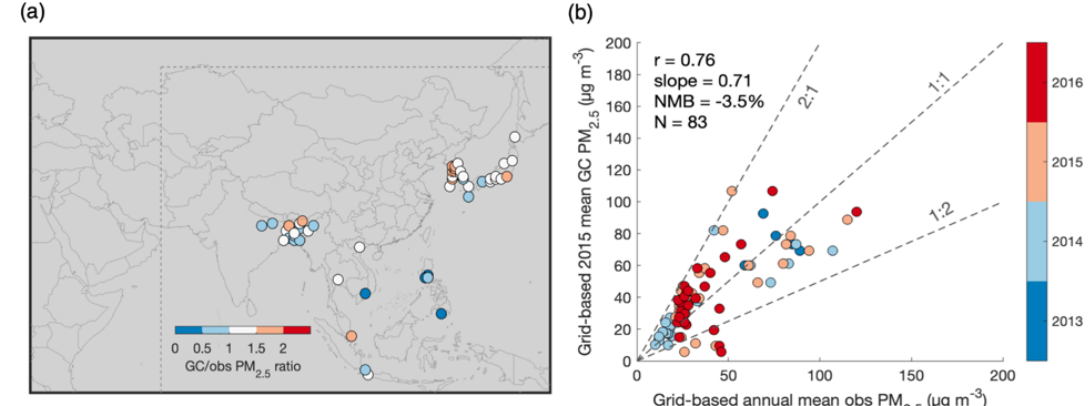
Figure 2. Annual-mean PM 2 . 5 concentrations at anthropogenic-emission-dominated sites in the simulation domain outside China. (a) The spatial distribution of simulated and observed PM 2 . 5 concentration ratios. The simulated concentration at each measurement site represents the 0.5 ◦ × 0.625 ◦ grid cell covering that site. Dashed lines represent the default nested Asia domain (11 ◦ S–55 ◦ N, 60–150 ◦ E) in the model. The flex-grid domain in our study is shown as the entire domain of the map. (b) Scatterplot comparing simulated concentrations for 2015 with collocated observations from the WHO for